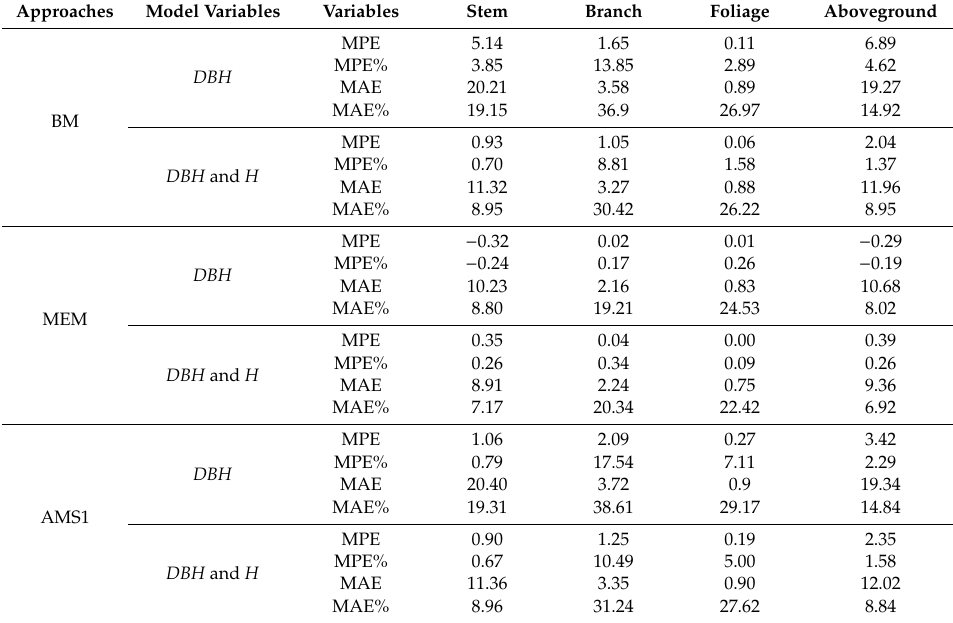
Table 6. Jackknifing validation of the six biomass modeling